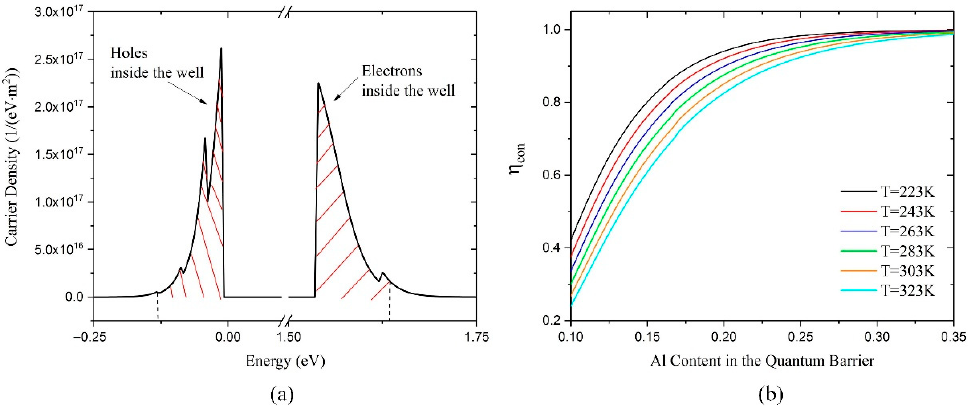
Figure 1. Simulated carrier confinement efficiency model: ( a ) the carrier concentration distribution with energy level for In 0.14 Al 0.14 Ga 0.72 As/Al 0.25 Ga 0.75 As quantum well at 223 K ( b ) carrier confinement efficiency vs. Al content of the quantum barrier at different temperatures. Table 3. Al content of quantum barrier that satisfies 𝜂 (cid:3030)(cid:3042)(cid:3041) = 96%